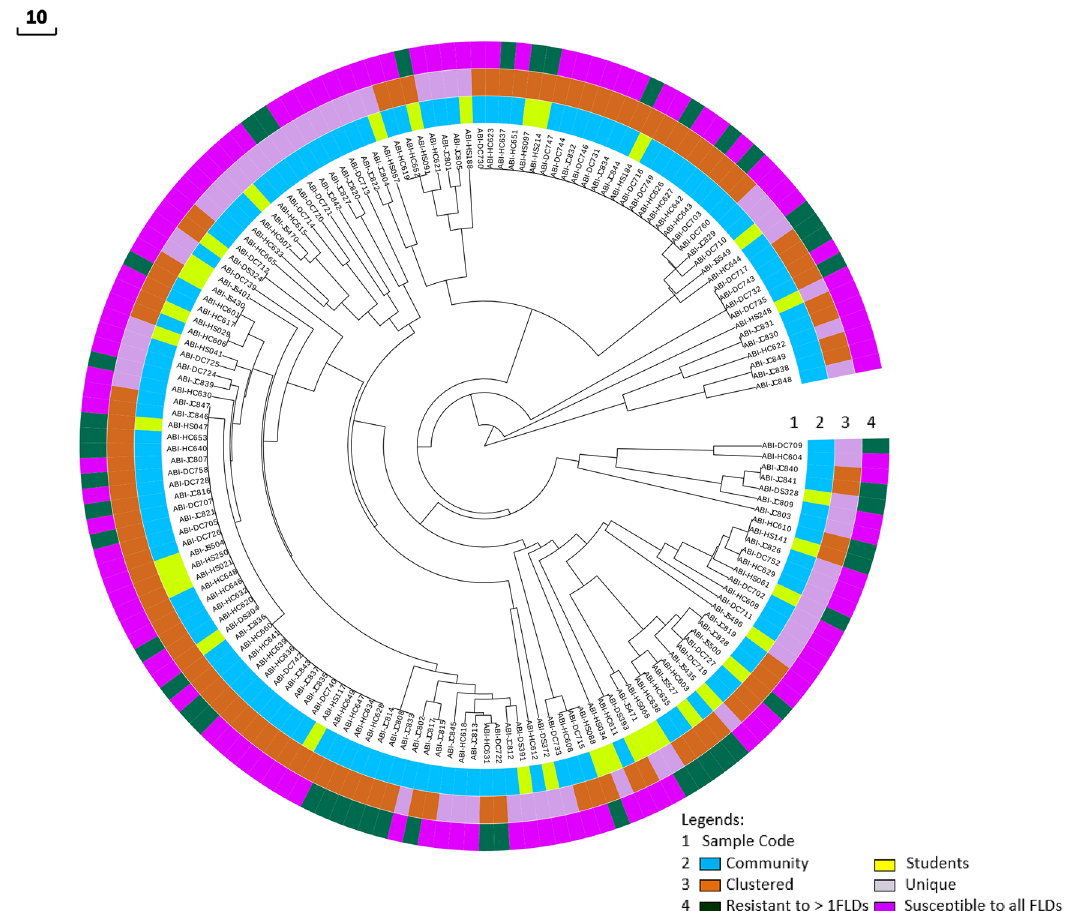
Fig 2. Visualization of PTB cases using a radial UPGMA tree based on 24-loci MIRU-VNTR data. Ring 4 shows drug resistance categories per isolate: fully susceptible (pink), at least one first-line drug resistance (dark green). Ring 3 shows whether cases were part of a genetic cluster (orange) or were unique (purple). Ring 2 differentiates students (yellow) from community members